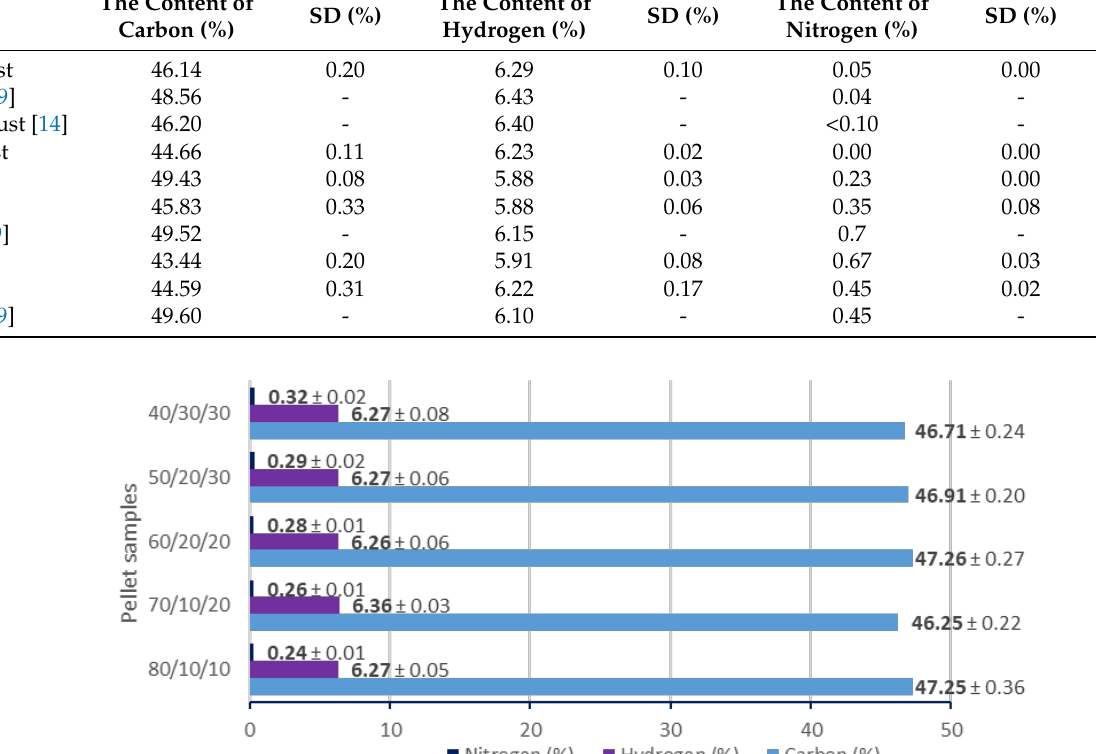
Figure 3. Results from elemental analysis of produced pellets.